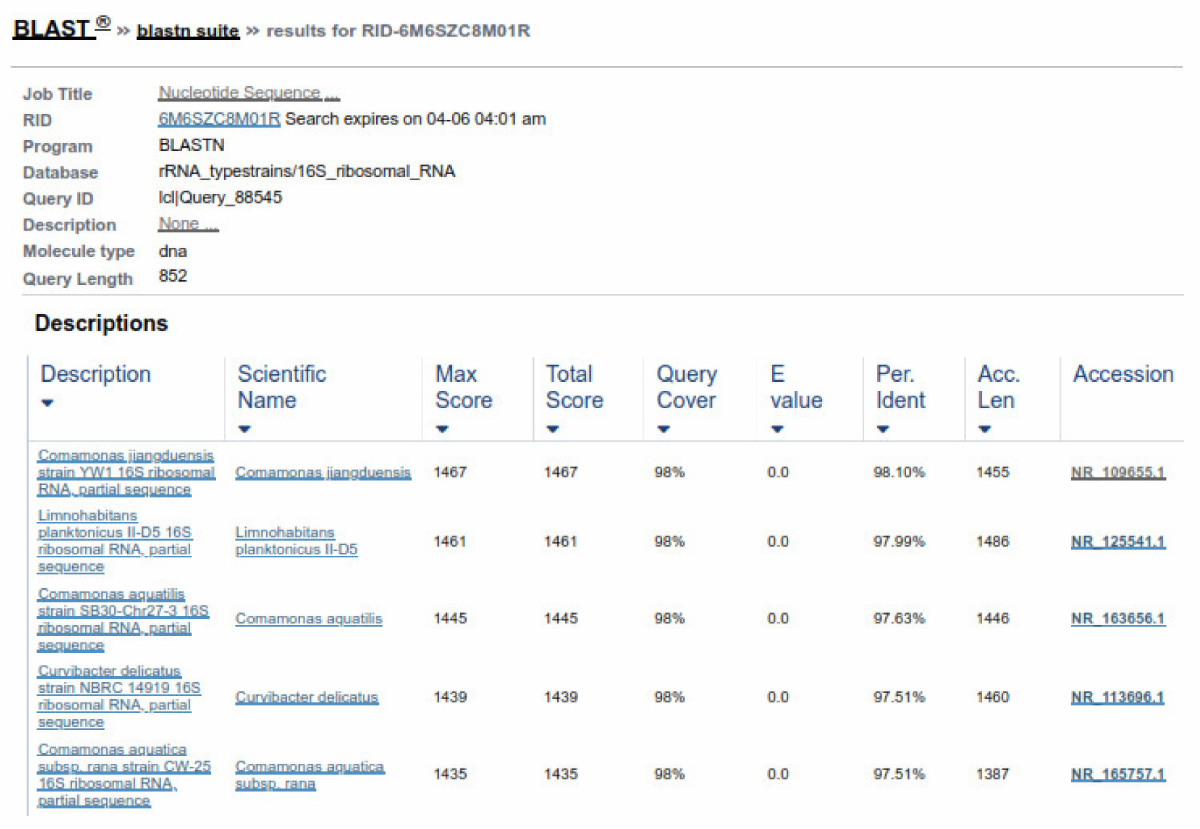
Figure 8. Sequence similarity of ABP with Comamonas testosteroni .